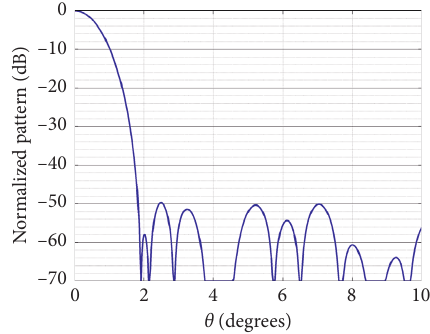
Figure 14: The two-way array pattern for N